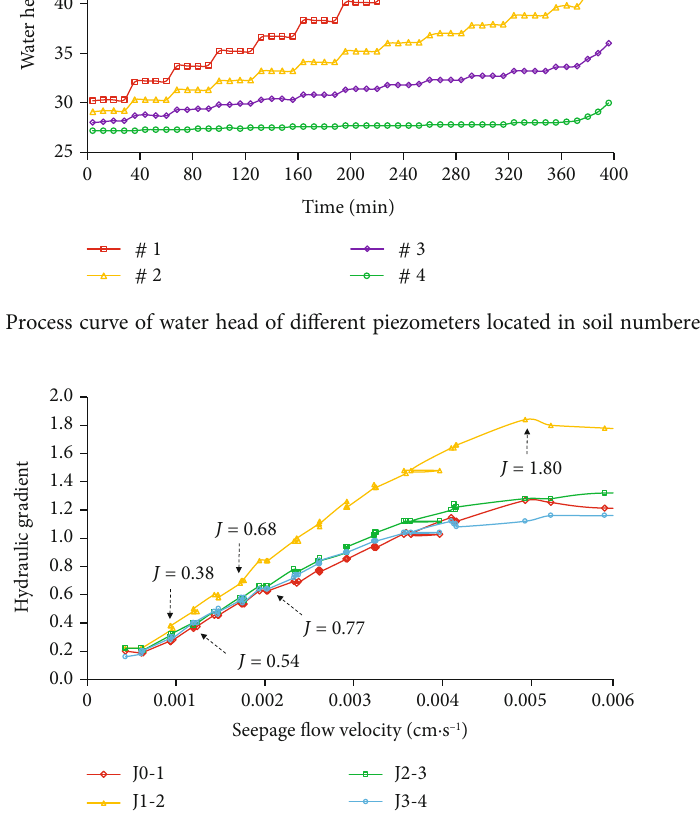
Figure 9: Process curve between hydraulic gradient and seepage fl ow velocity of di ff erent parts in soil numbered